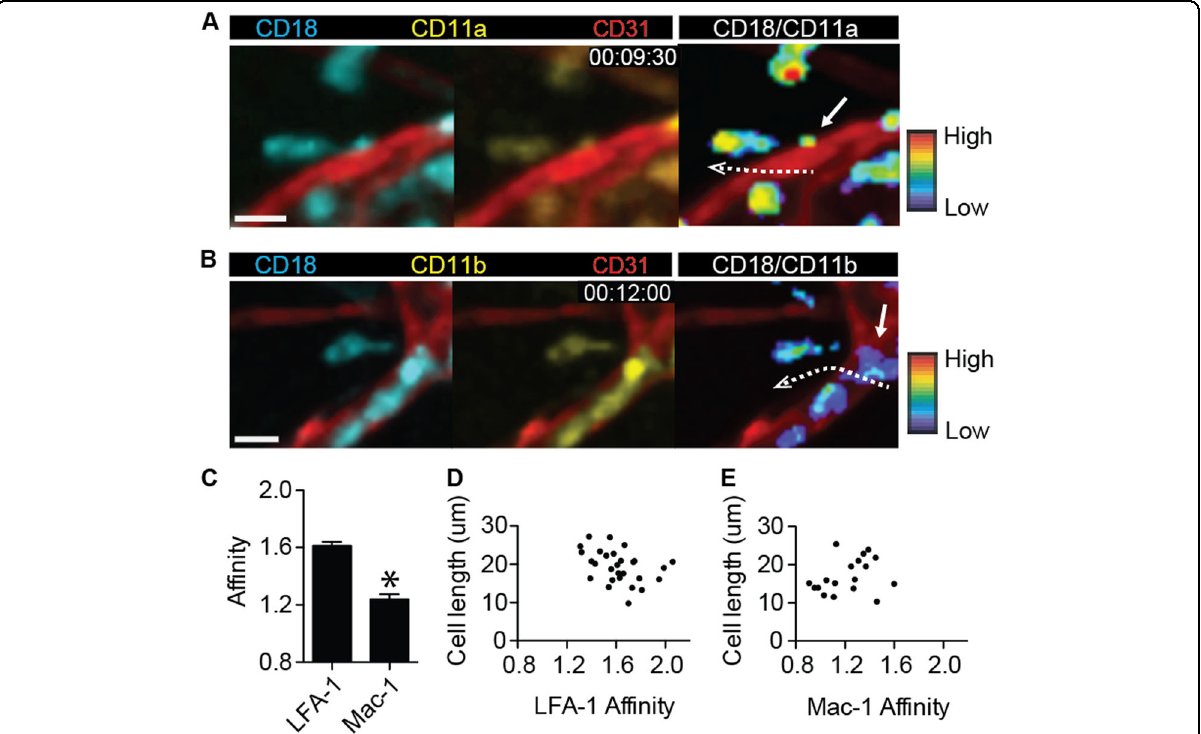
Fig. 5 High-af fi nity LFA-1 is localized at the trailing edge of the neutrophil during the elongation step of extravasation upon stimulation with N -formylmethionyl-leucyl-phenylalanine. a CD18 expression (upper left panel), CD11a expression (upper right panel), Alexa 594-anti-CD31 antibody staining of an endothelial cellular border, and the CD18-to-CD11a ratio (lower right panel), visualized in the step of uropod elongation of a neutrophil in LFA-1 FRET (CD11a-mYFP/CD18-mCFP) mice. Two-photon intravital imaging of LFA-1 FRET mice was performed. The cyan fl uorescent protein/yellow fl uorescent protein (CFP/YFP) ratio is visualized using the rainbow scale. The arrow indicates LFA-1 af fi nity status at the trailing edge of an elongated neutrophil. The dotted arrow indicates the elongation of an extravasating neutrophil. Scale bar, 10 μ m. See Video 10. The images are representative of at least fi ve independent videos. b CD18 expression (upper left panel), CD11b expression (upper right panel), Alexa 594-anti-CD31 antibody staining of an endothelial cellular border, and the CD18-to-CD11a ratio (lower right panel), visualized in the step of uropod elongation of a neutrophil in Mac-1 FRET (CD11b-mYFP/CD18-mCFP) mice. Two-photon intravital imaging of Mac-1 FRET mice was performed. The CFP/YFP ratio was visualized using the rainbow scale. The arrow indicates the Mac-1 af fi nity status at the trailing edge of an elongated neutrophil. The dotted arrow indicates the elongation of an extravasating neutrophil. Scale bar, 10 μ m. See Video 11. The images are representative of at least fi ve independent videos. c The af fi nities of LFA-1 and Mac-1 were compared at the trailing edges of neutrophils during uropod elongation. * P < 0.0001. d Plot of the correlation of cell length with LFA-1 af fi nity. Data from two-photon intravital imaging of neutrophils in LFA-1 FRET mice during uropod elongation, as the fi nal step of neutrophil extravasation, were analyzed. A dot indicates the correlation value of an elongated neutrophil. e Plot of the correlation of cell length with Mac-1 af fi nity. Data from two-photon intravital imaging of neutrophils in Mac-1 FRET mice during uropod elongation, as the fi nal step of neutrophil extravasation, were analyzed. A dot indicates the correlation value of an elongated